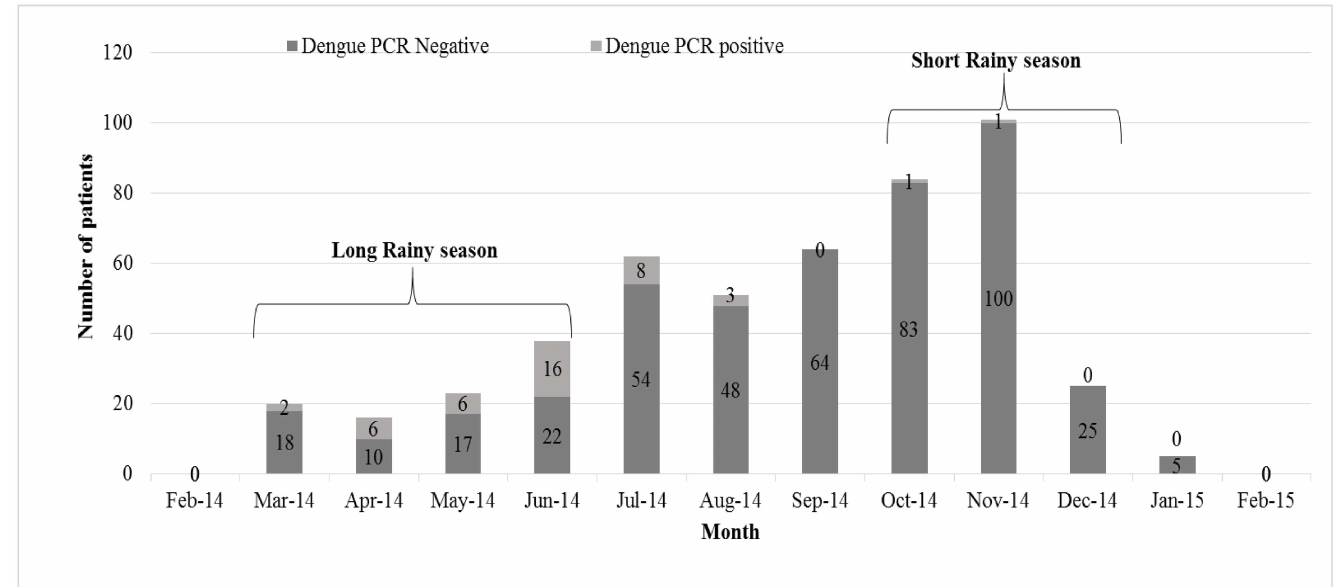
Fig 2. Study participants with and without dengue viral infection (N =